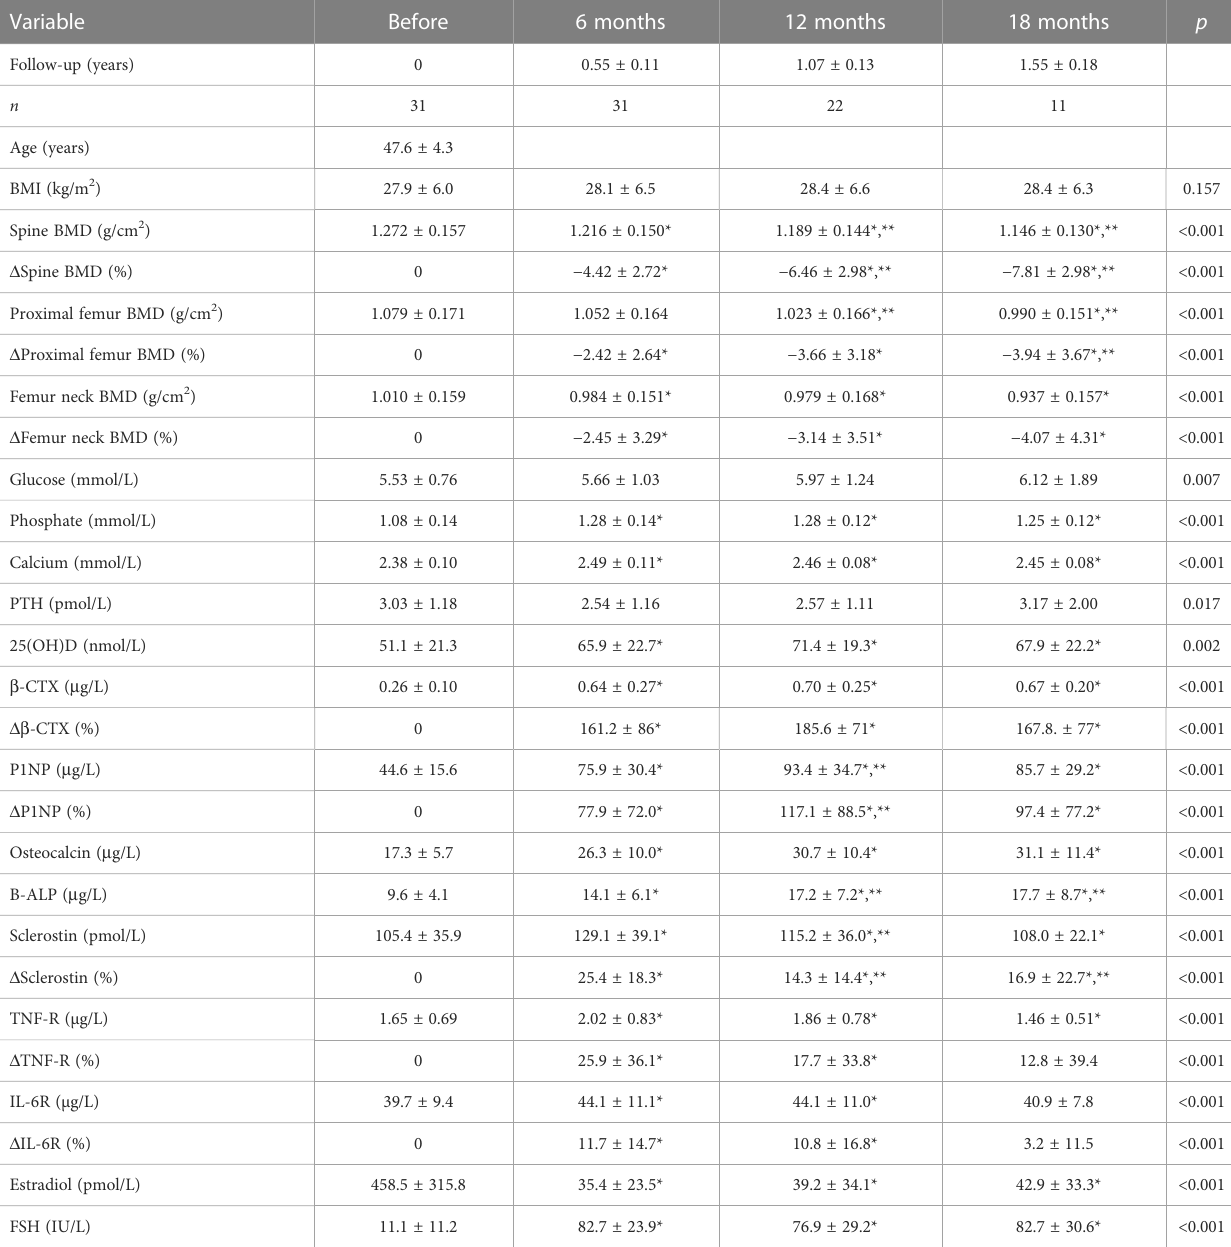
TABLE 1 Prospective laboratory data in women before and after oophorectomy. Variable